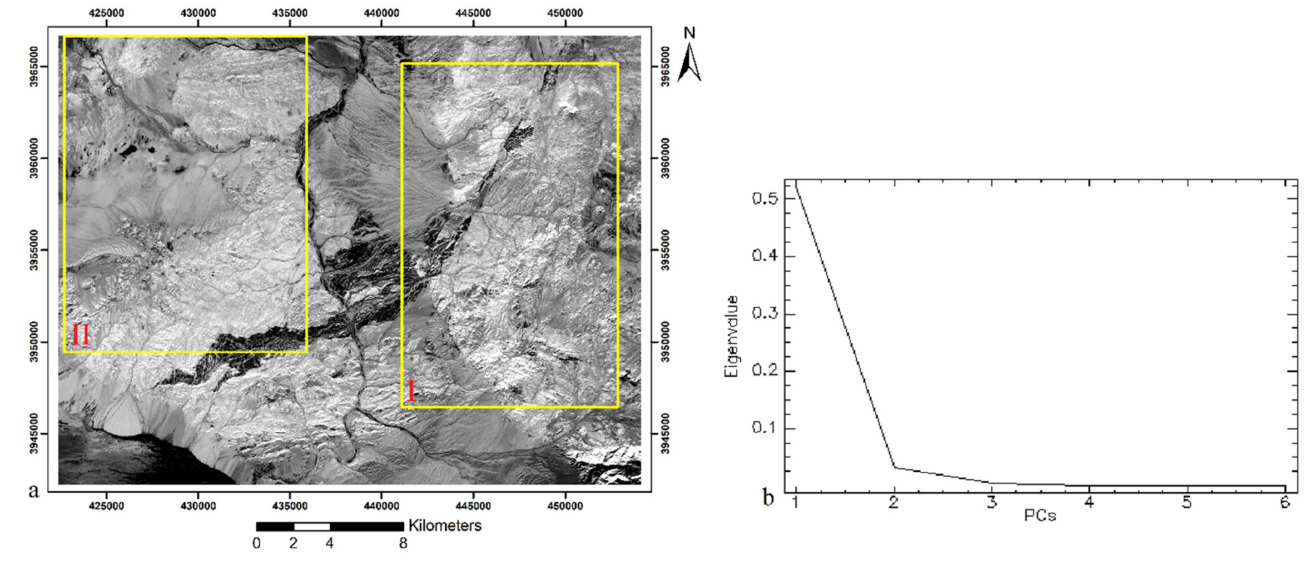
Figure 6. ( a ) PC1 image in the study area; ( b ) eigenvector obtained from PCA of six Sentinel-2 MSI bands (bands 2, 3, 4, 8, 11 and